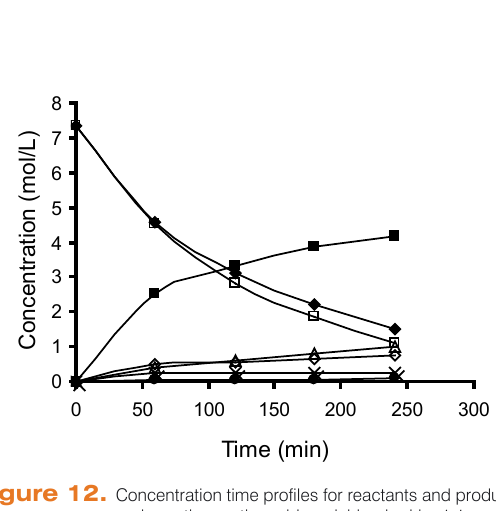
molar ratio acetic acid: epichlorohydrin 1:1; speed of agitation 600 rpm; catalyst loading (112.5 kg m -3 ); temperature 366 K; ♦ acetic acid ; □ epichlorohydrin; ■ 3-chloro-2-hydroxypropyl acetate; ∆ 2-chloro-1- (hydroxymethyl)ethyl acetate; ◊ dichlorohydrin glycer - ine; x glycidyl acetate; ● 3-chloro-2-(3-chloro-2-hydrox - ypropoxy)propyl